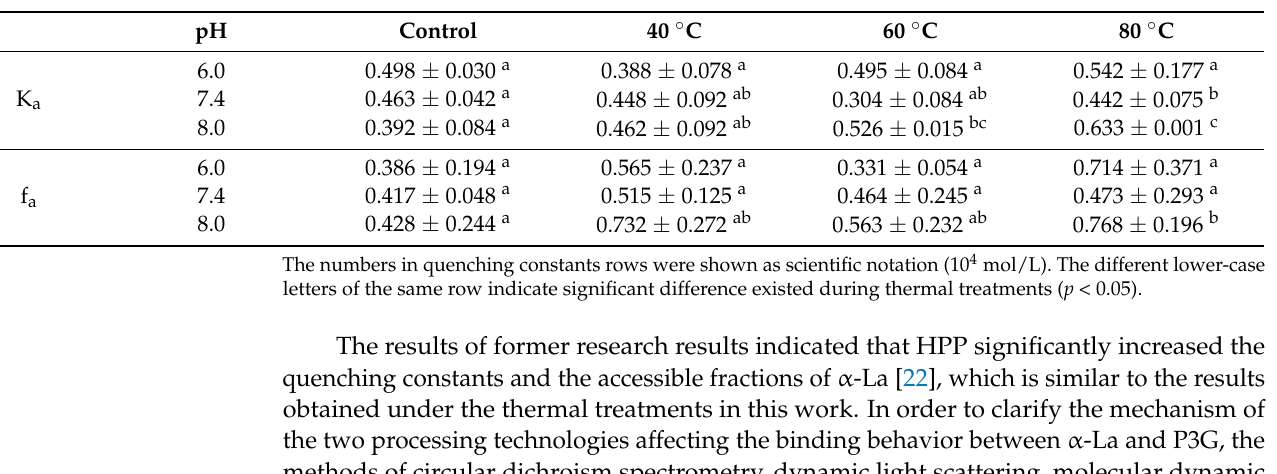
Table 1. The quenching constants and accessible fractions at different thermal